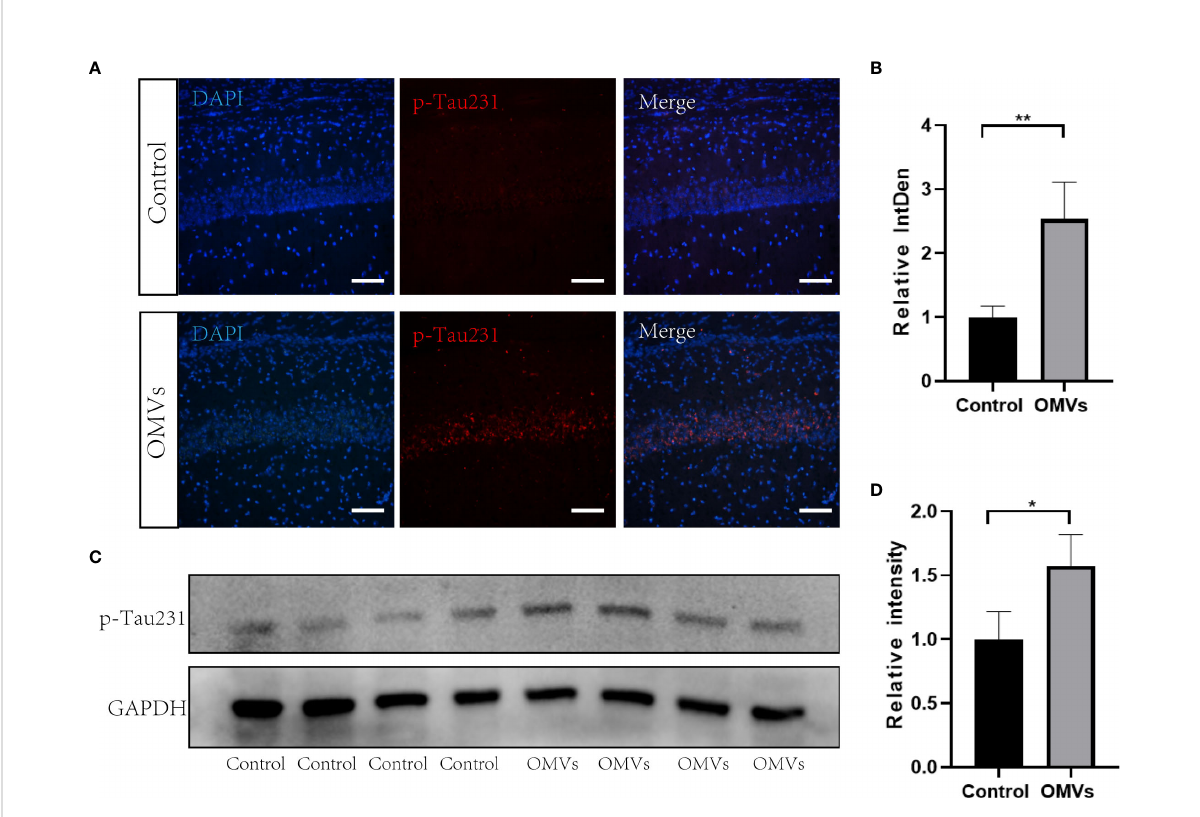
FIGURE 6 Oral gavage of Pg OMVs increases tau phosphorylation in the hippocampus of mice. (A) Immuno fl uorescent images of p-Tau231 (red) in the hippocampus of mice. Scale bar = 50 m m. (B) Mean relative fl uorescence intensity (relative integrated density) of p-Tau231 in image (A) ( n = 3, ** p <.01, Student ’ s t -test). (C) The Western blots showing p-Tau231 in the hippocampus of mice. (D) The quantitative analyses of the ratio of p- Tau231 immunoblots in the image (C) ( n = 4, * p